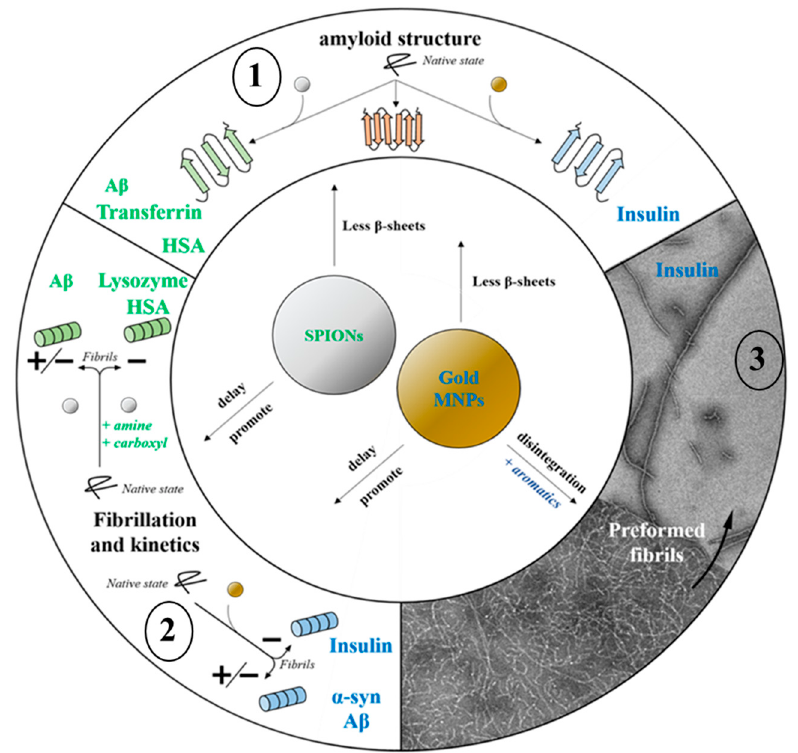
Figure 2. MNPs impacts on various in vitro amyloid aggregates. According their size, shape, charge, and type of functionalization, MNPs can: ( 1 ) affect amyloid structure at the protein level by decreasing β -sheet content; ( 2 ) inhibit, delay, or promote protein fibrillation and elongation into fibers; and ( 3 ) promote disassembly of amyloid fibers. HSA, human serum albumin.